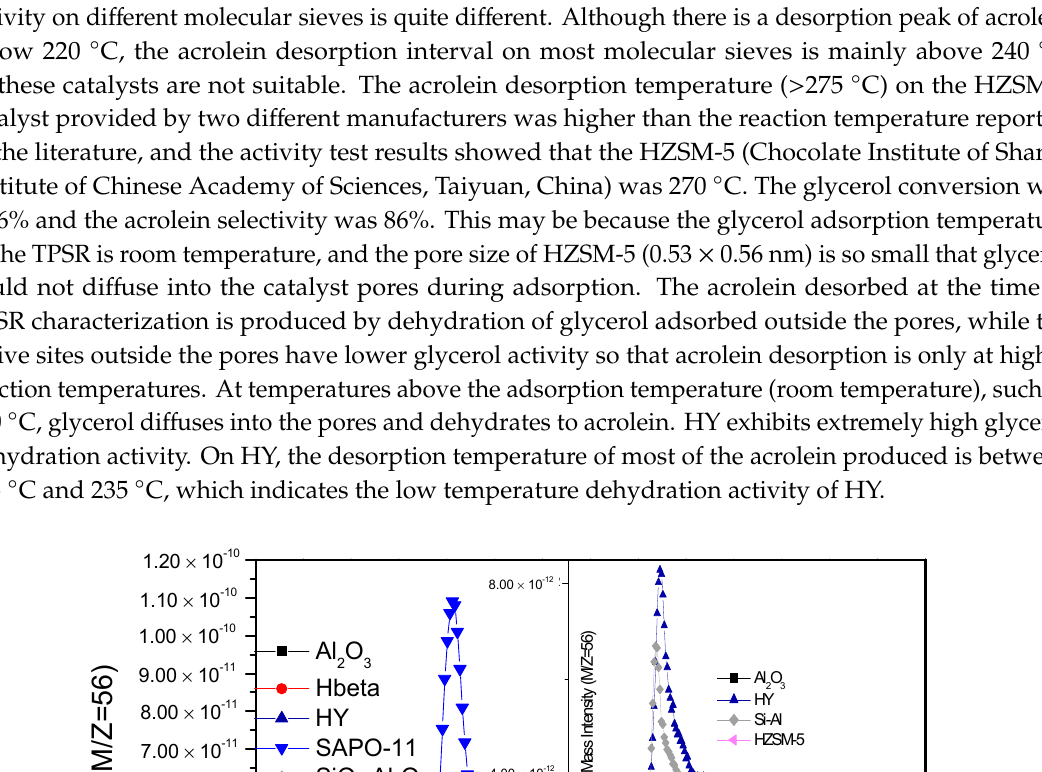
Figure 6. Acrolein in the TPSR of super acid. 2.2. Catalytic Performance of Different Catalysts and Fixed-Bed Reactions Table 3 lists the catalytic activity of the solid acid catalysts at 210 °C, and the selectivity to acrolein was low with several by-products such as acetol, propanal, and acetaldehyde. Among them, STA/SiO 2 and SO 42 − /TiO 2 showed high yields of acrolein over 80%. Four solid acid catalysts with low temperature activity selected by TPSR were evaluated under 210 °C and hydrogen conditions. On HY and SO 42 − /ZrO 2 catalysts, the material balance is much lower than the reasonable range (<50%) due to two reasons. The first reason is the formation of a large amount of carbon on the catalyst surface and the second reason is that the formed brown viscous liquid sample was too viscous to flow out when entering the cold trap. The viscous liquid was washed by deionized water and analyzed by GC-MS, which were mostly unknown high boiling products and glycerol, but no acrolein. Considering that a part of the glycerin is present in the viscous liquid, which is not collected, only the yield (the amount of acrolein detected/the amount of glycerin fed) is calculated for the two catalysts.